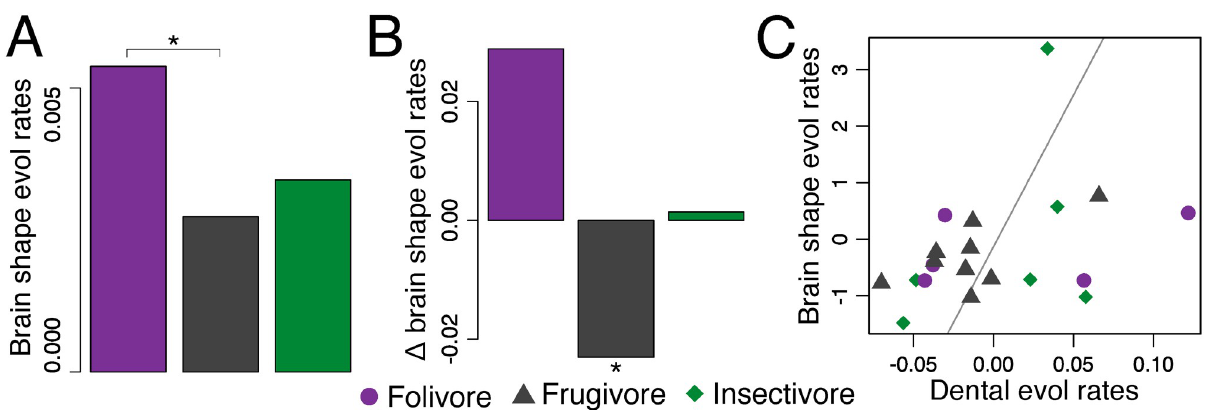
Fig 3. Comparisons of rates of brain shape evolution across dietary guilds. Pairwise comparisons of per-guild evolutionary rates in brain shape (A); differences in per-species rates of evolution averaged by guild and compared to the average rate for all strepsirrhines combined (B); partial least square analysis of integration between per-species rates of evolution of brain shape and dental morphology (C). � Represents statistical significance at P < 0.05.